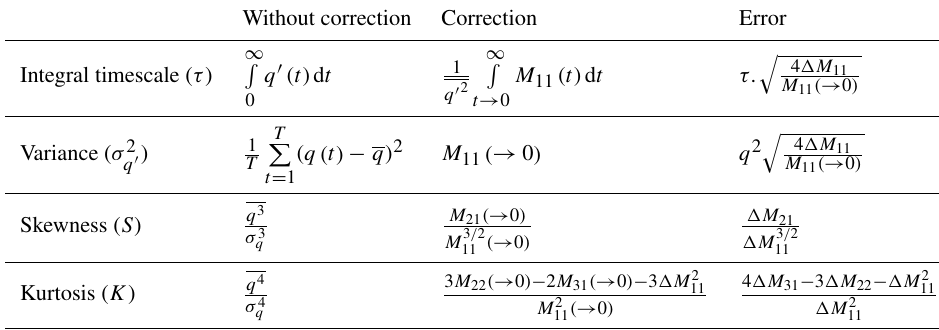
Table 1. Variables applied to statistical analysis (Lenschow et al., 2000). Without correction Correction Error Integral timescale ( τ